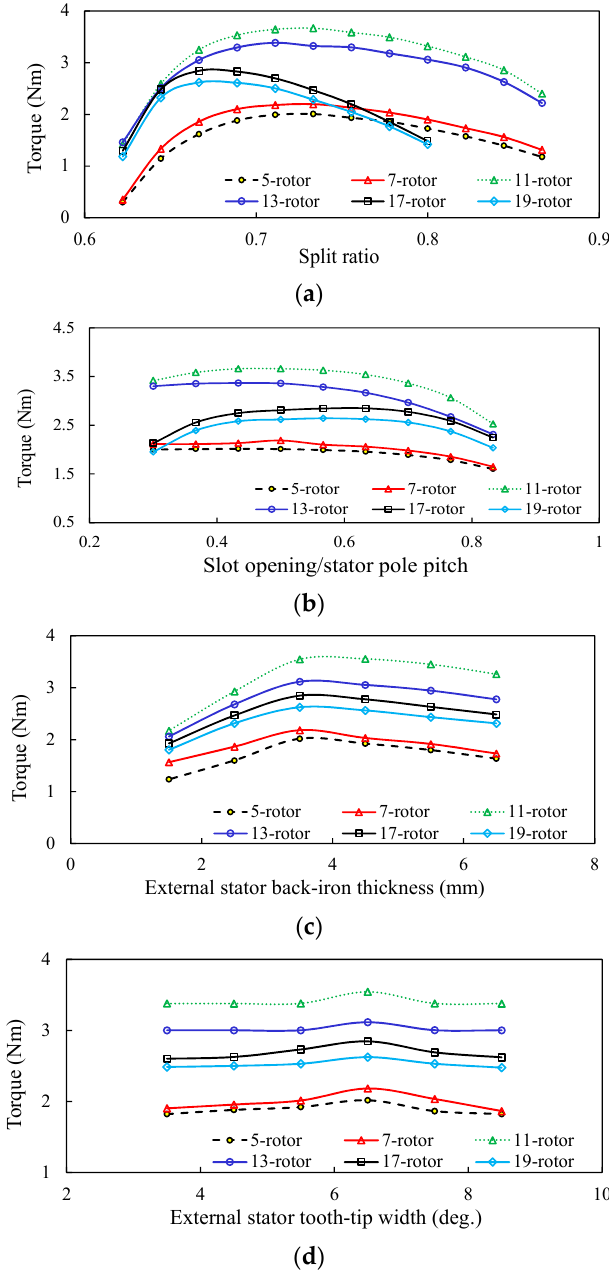
Figure 7. Variation of average torque with various stator design parameters, I d = 0, copper loss = 30 W. ( a ) Split ratio; ( b ) Slot opening ratio; ( c ) Outer stator back-iron thickness; ( d ) Outer stator tooth-tip width.